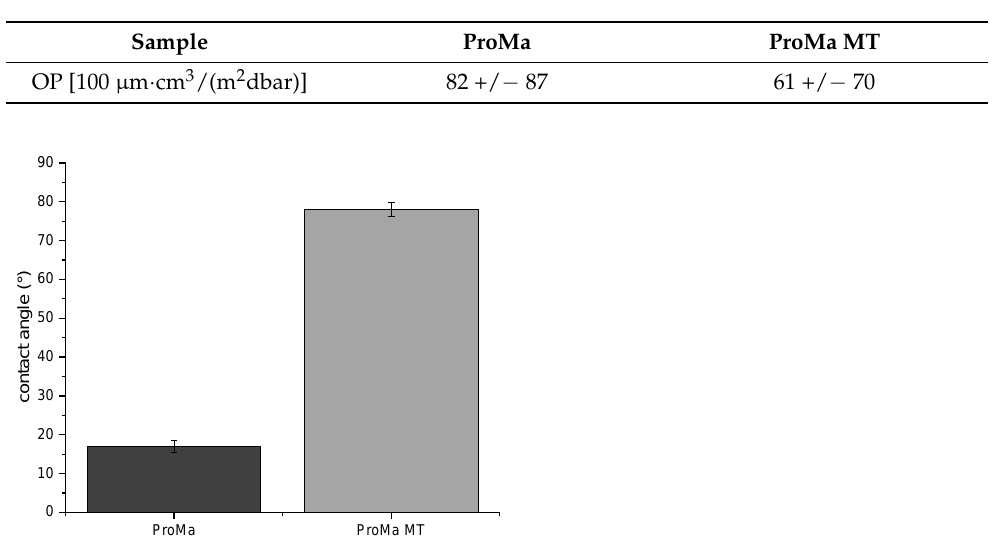
Figure 5. The contact angle [ ◦ ] of the ProMa coating and ProMa + trimethylethoxysilane on the glass (5 cm × 5 cm) coated and dried by 80 ◦ C for 2